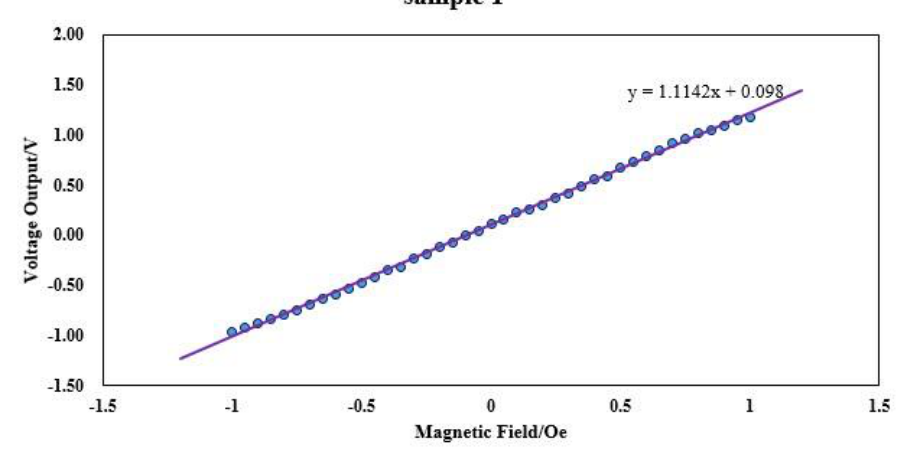
Figure 10. The result of linear fitting of the data of sample 1.